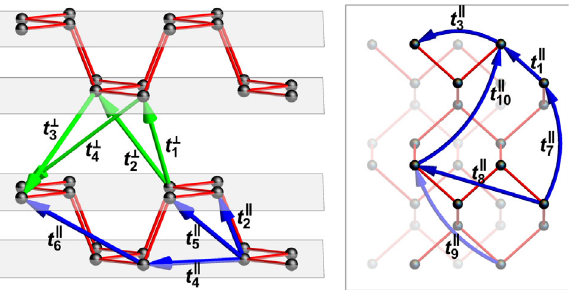
FIG. 5. Hopping amplitudes between p multilayer. See Table II for their